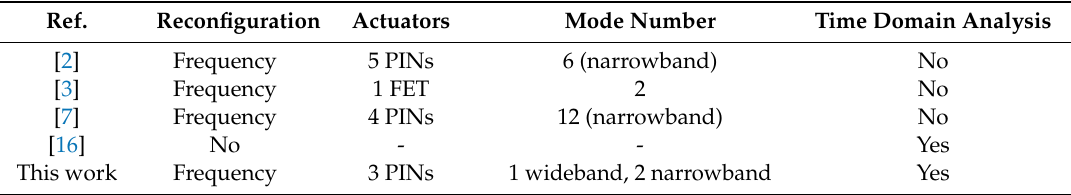
Table 5. Performance comparison with other designs in the